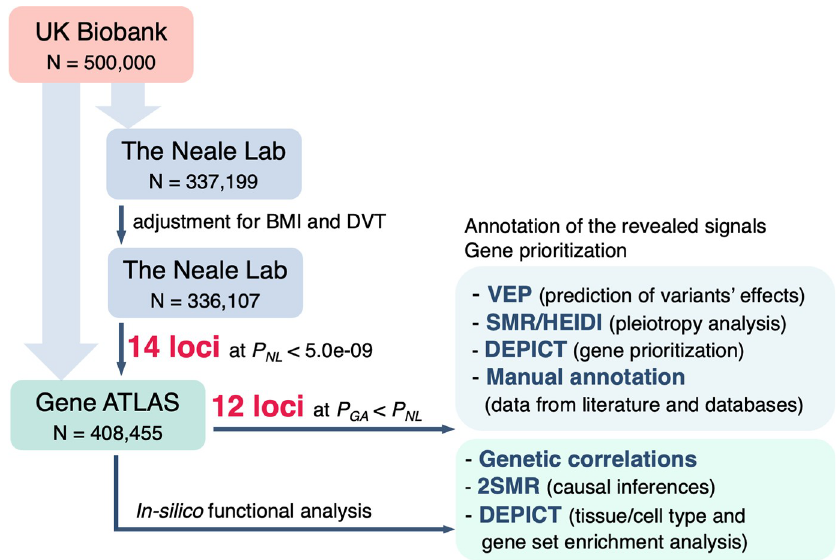
Fig 1. Scheme depicting the overall workflow of our study. GWAS summary statistics for VVs was obtained from the Gene ATLAS (larger sample size, less stringent filtering criteria) and the Neale Lab database (smaller sample size, more stringent filtering criteria). Search for associated loci was performed using the Neale Lab data adjusted for two potential confounders–body mass index (BMI) and deep venous thrombosis (DVT). GWAS summary statistics for these two traits were also obtained from the Neale Lab database. Since our study design did not imply a replication stage, genome-wide significance threshold was set at 5.0e-09. To be more rigorous, we filtered out those loci for which P -values in the Gene ATLAS dataset were higher than the corresponding P -values in the Neale Lab dataset (after all corrections). For the resulting 12 loci, we performed a functional annotation analysis and prioritized the most likely causal genes. Except for VEP, all in-silico analyses were conducted using the Gene ATLAS dataset since it enables to achieve the highest statistical power and is genetically equivalent to other studied VVs datasets (genetic correlation coefficient = 0.99–1.00, S1